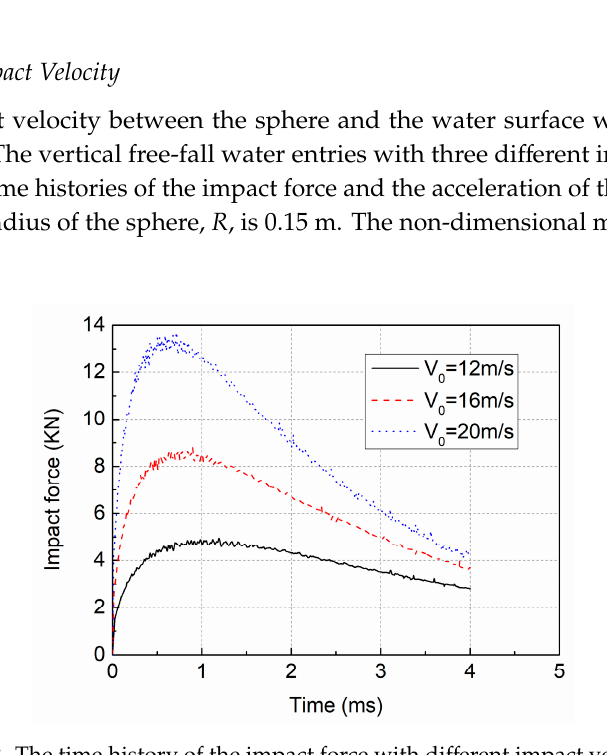
Figure 7. The comparison of non-dimensional impact force between the present method and the previous experimental and numerical results.